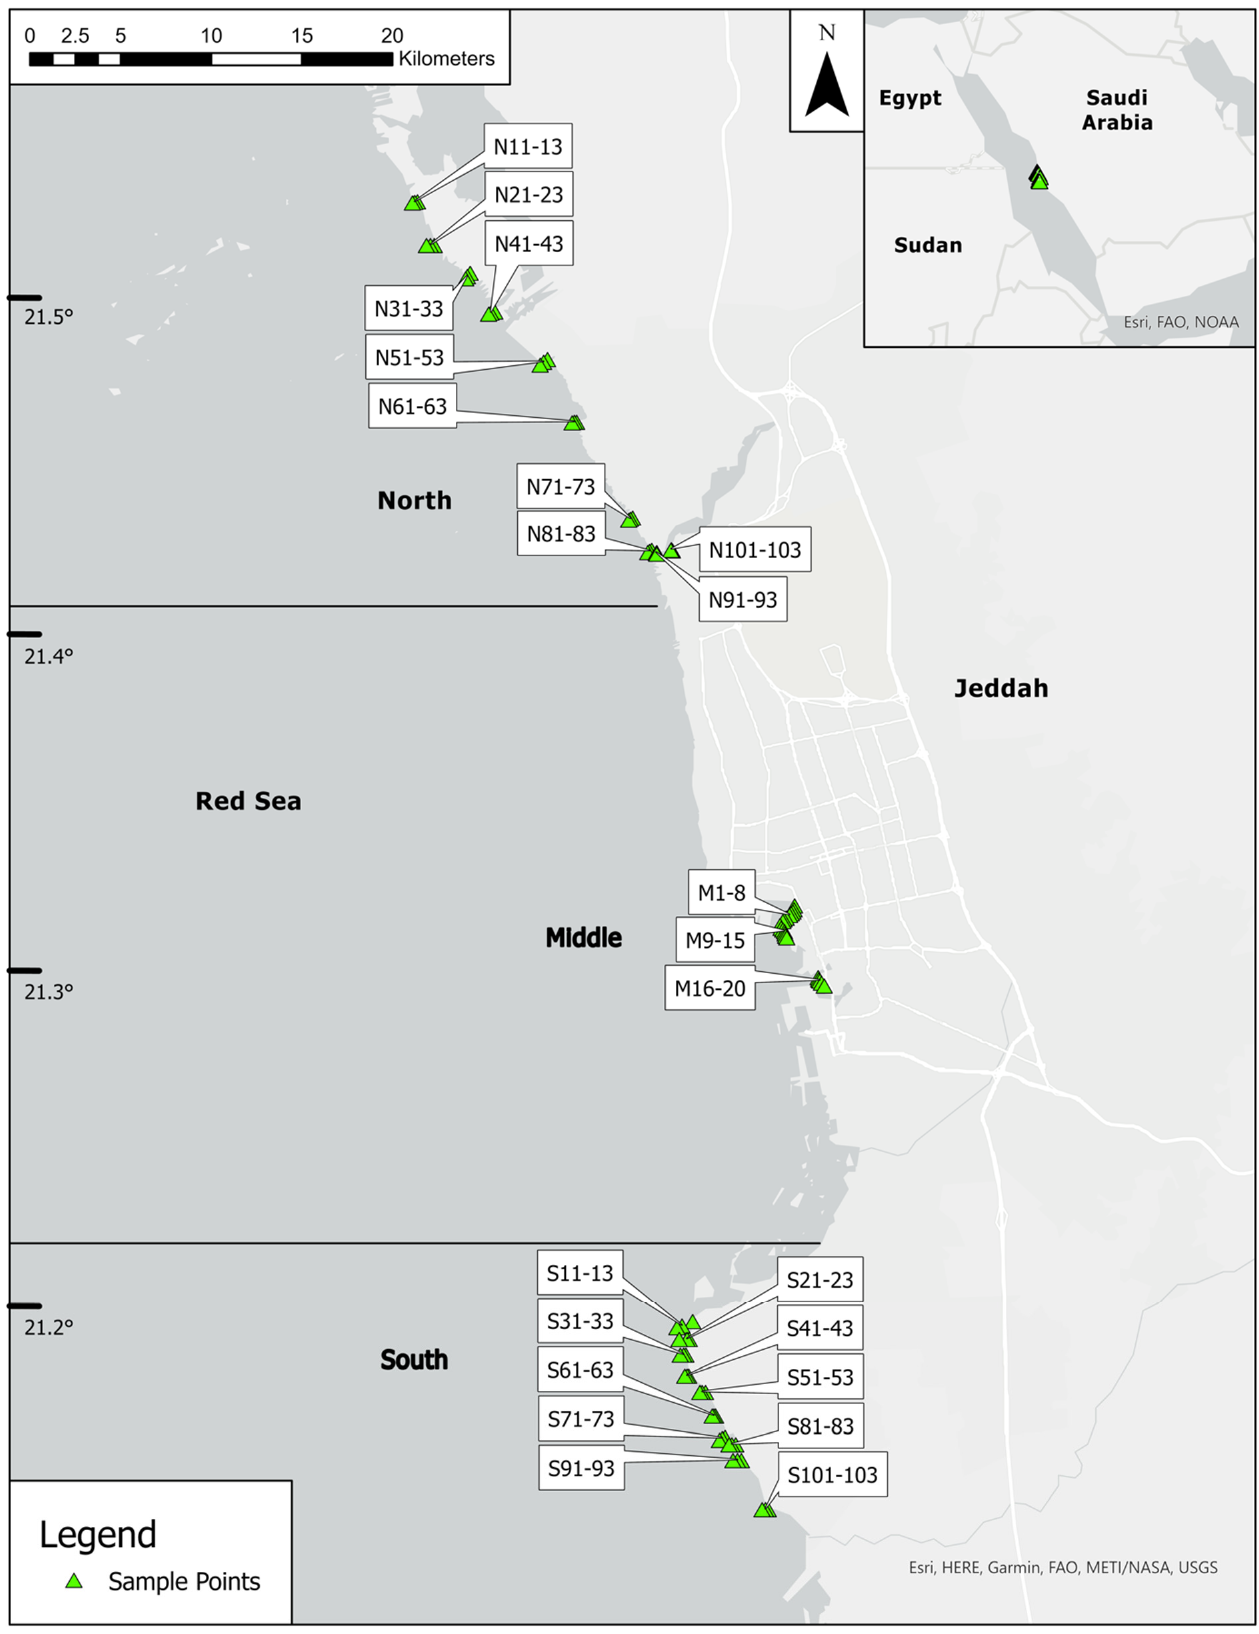
Figure 1. Map of the study region with broader geographical region shown in the inset. Horizontal lines delineate North, Middle, and South locations. The locations of specific sediment sampling points are labeled.